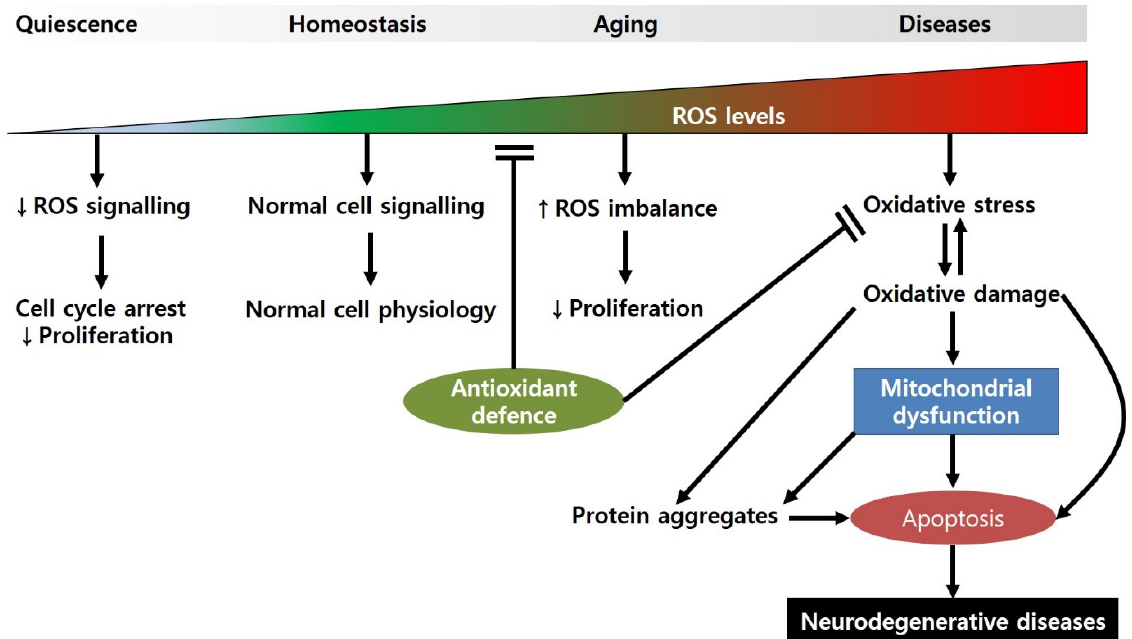
Figure 1. Regulation of cellular physiology by ROS levels. When ROS levels are very low, the cell cycle can be arrested, and proliferation is slowed. Under normal ROS levels, cells show normal cell physiology (e.g., cellular homeostasis, cell division, synaptic plasticity, etc.) by maintaining appropriate signalling pathways. However, during the aging processes, ROS production is increased due to the attenuated antioxidant defence, resulting in decreased proliferation. When ROS levels are high, they can induce oxidative-stress-induced damage to biomolecules, causing mitochondrial dysfunction and apoptotic cell death.